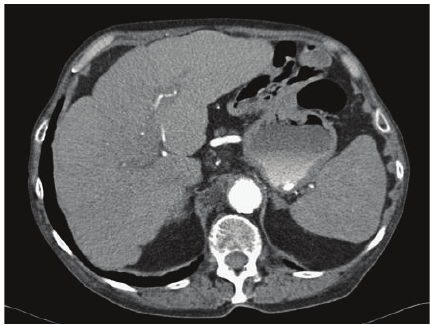
Figure 1: CT scan showing nodular liver contour, indicative of early hepatic injury and cirrhosis. Patient started using black cohosh a month before developing jaundice She presented to the primary cares office a week before hospitalization, w as found to have elevated liver enzymes, and was given short course of steroids (see case for details)